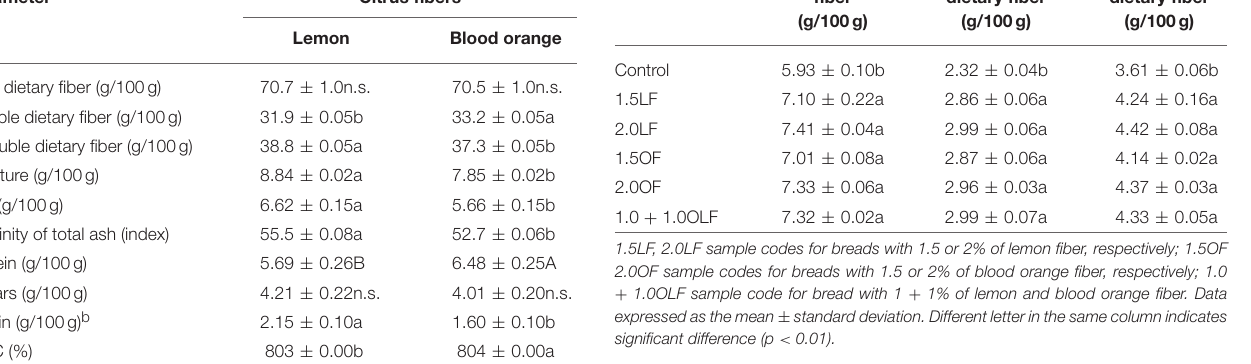
TABLE 2 | Chemical characterization of citrus (lemon and blood orange) fiber used in bread making. Parameter Citrus fibers